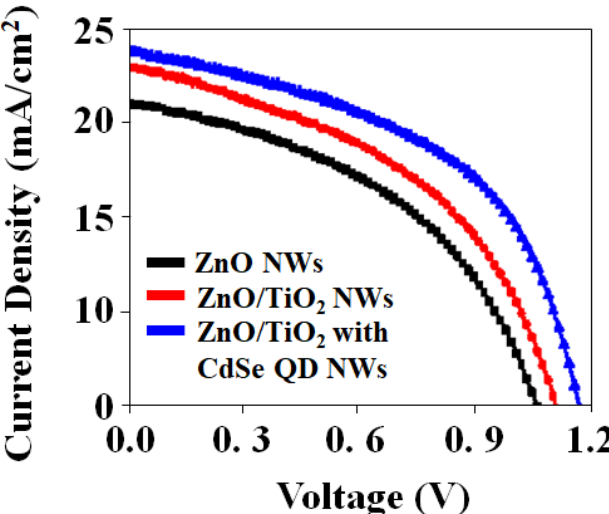
Figure 2. Photocurrent density–voltage (J–V) characteristics of perovskite solar cells (PSCs) based on ZnO/TiO 2 core/shell arrays with AgCl-doped CdSe quantum dots under 100 mW/cm 2 of AM 1.5